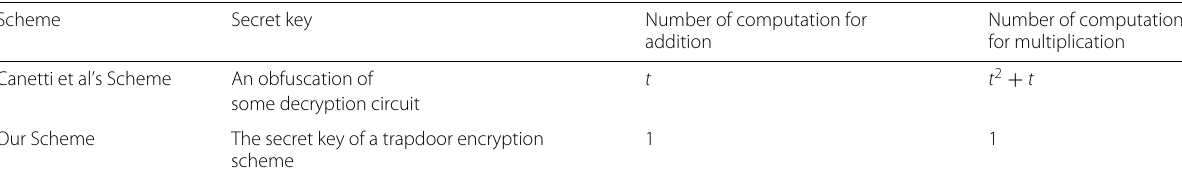
Table 1 The comparison between Canetti et al’s scheme and our scheme Scheme Secret key Number of computation for Number of computation addition for multiplication Canetti et al’s Scheme An obfuscation of t t 2 + t some decryption circuit Our Scheme The secret key of a trapdoor encryption scheme